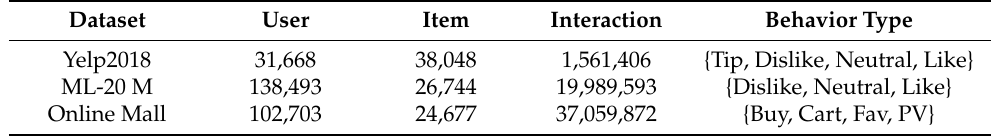
Table 1. Experimental dataset